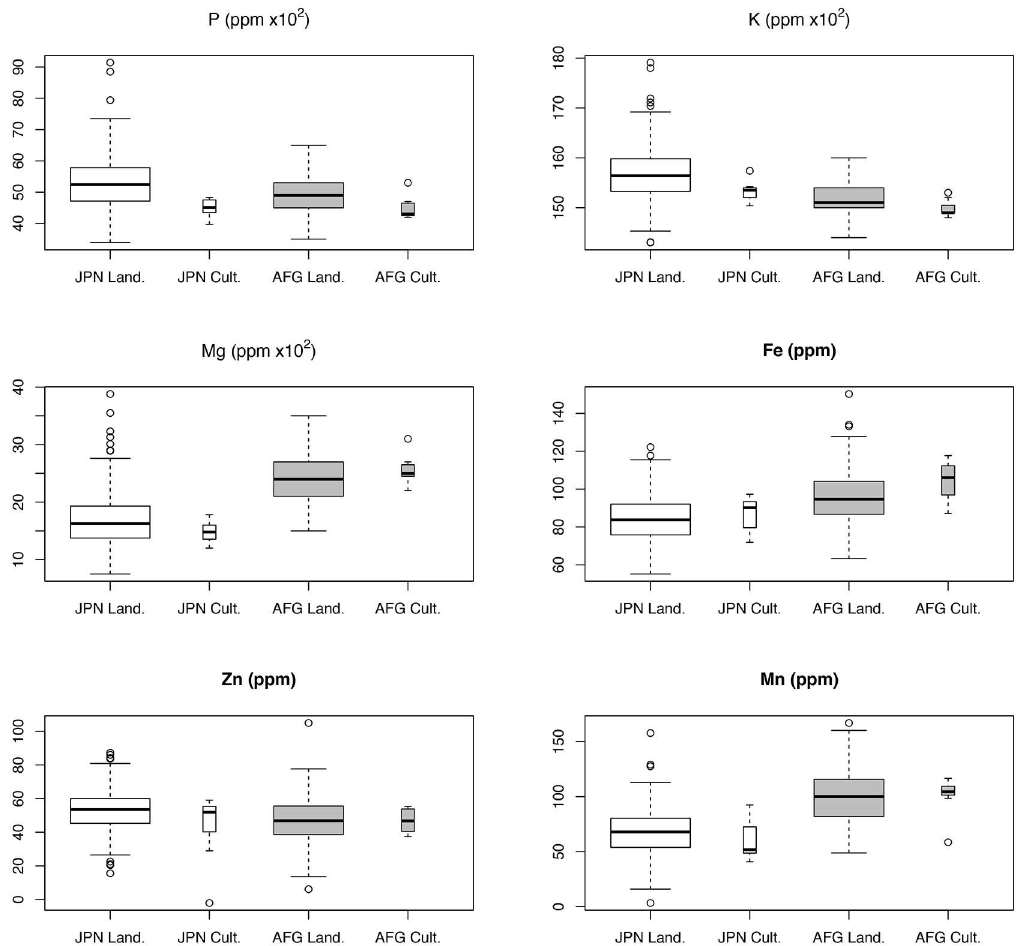
Fig 1. Boxplots of elemental contents in 269 Kihara Afghan wheat landraces and seven check cultivars. Results for Japanand Afghanistan are indicatedin white and grey, respectively.